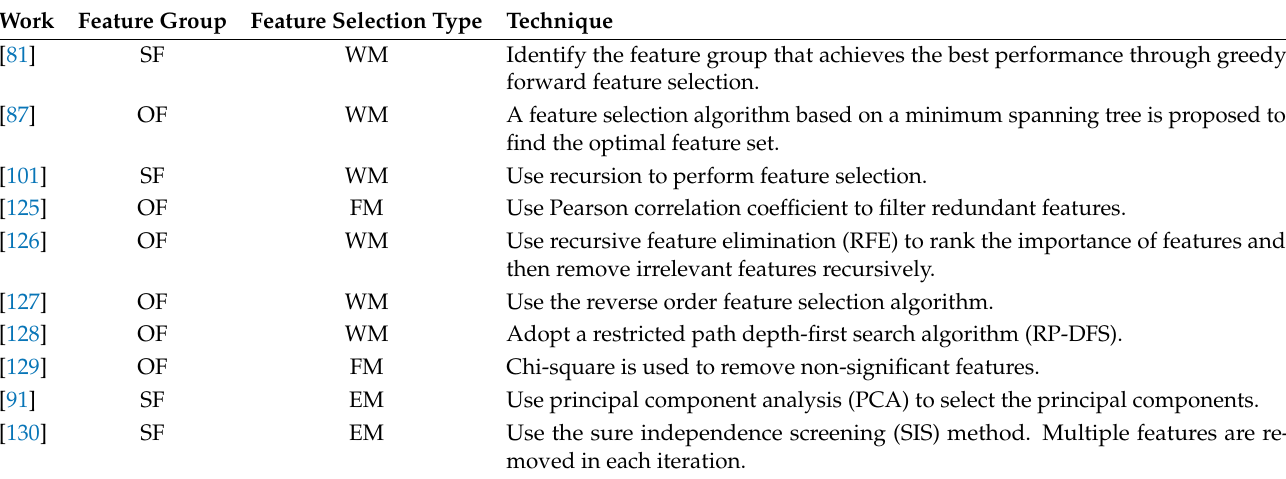
Table 2. Summary of feature selection techniques related to ASD. Work Feature Group Feature Selection Type